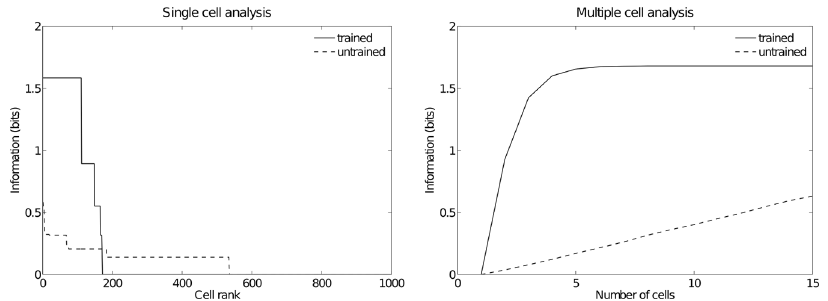
Figure 5. Information analysis. Analysis of the information about where the target object is with respect to the hand conveyed by the output (fourth) layer neurons before and after training. The left plot shows the amount of single cell information carried by individual output cells in rank order. It can be seen that training the network has produced a large increase in the information carried by the output cells. In particular, after training, it was found that 111 cells reached the maximum amount of single cell information of 1.58 bits. In the untrained condition no cells reached maximal information. These cells responded perfectly to just one of the three hand-object configurations, and responded to that configuration across all five retinal locations. The right plot shows the multiple cell information measures calculated across 15 cells with maximal single cell information. It can be seen that, after training, the multiple cell information asymptotes to the maximal value of 1.58 bits. This confirms that all three hand-object configurations are represented by the output cells.